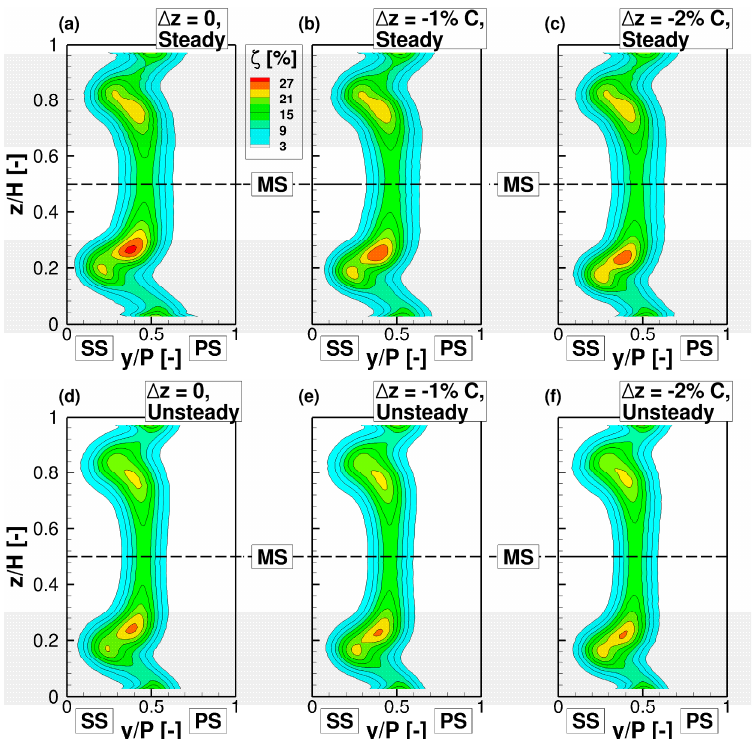
Figure 21. Measured total pressure losses at different endwall boundary layer conditions, ( a – c ) with and ( d – f ) without periodically incoming wakes in MP2.